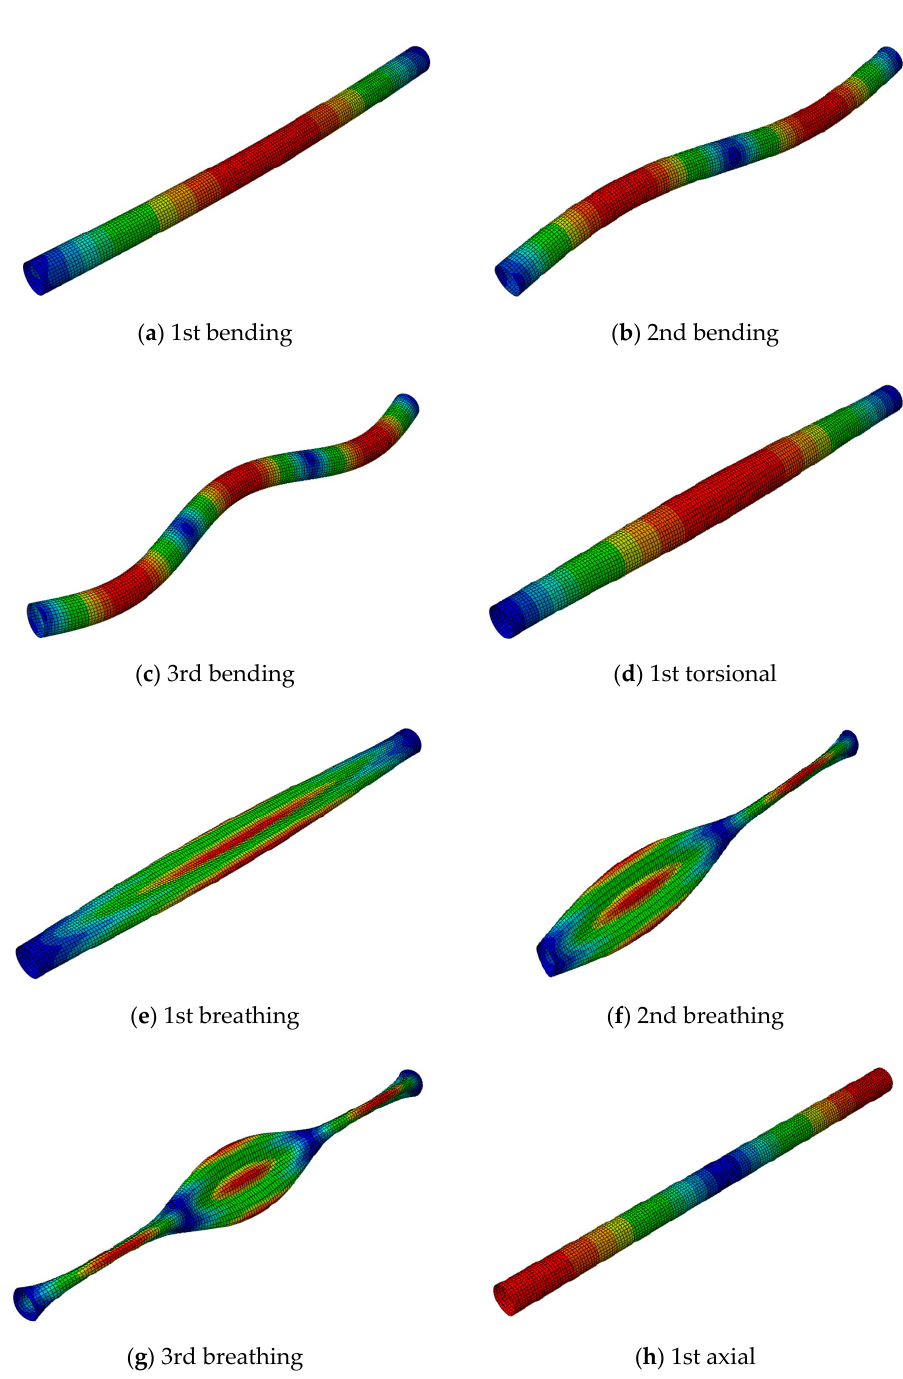
Figure 3. Set of the first eight mode shapes of natural frequency of a simply supported composite drive shaft. To detect deformation and natural frequencies, FEM analysis was conducted in Abaqus CAE. The corresponding frequency values were as follows: ( a ) 91.65, ( b ) 326.88, ( c ) 635.73, ( d ) 442.34, ( e ) 334.69, ( f ) 334.91, ( g ) 402.28, and ( h ) 1485.60 Hz.